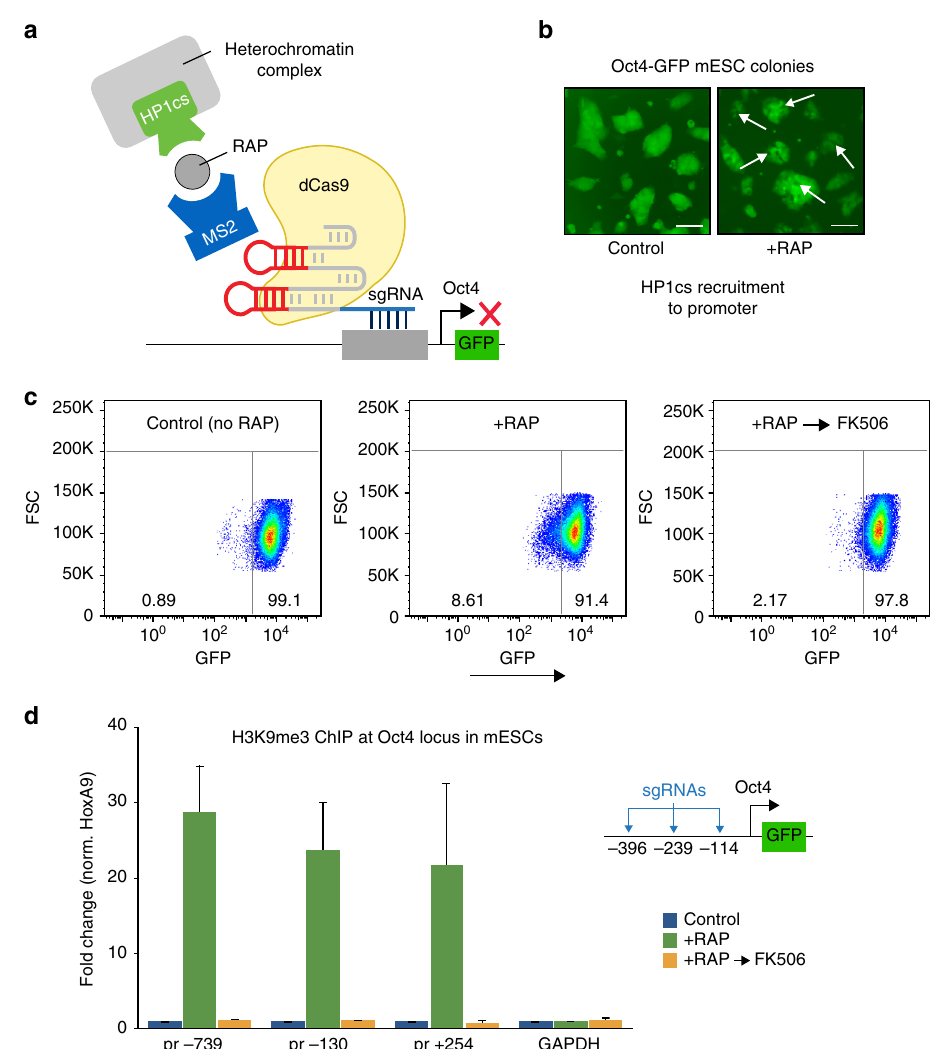
Fig. 2 Reversible heterochromatin complex recruitment regulates Oct4 expression in mESCs. a Schematic representation of heterochromatin complex recruitment to the Oct4 locus in reporter Oct4-GFP mESCs. b Microscopy reveals loss of GFP expression in Oct4-GFP mESC colonies 5 days after RAP treatment to induce HP1cs recruitment. Arrows show examples of GFP-negative cells within Oct4-GFP ESC colonies. Scale bar represents 100 µ m. c FACS analysis shows reversible repression of Oct4-GFP expression in mESCs. After 5 days of RAP to recruit HP1cs to the Oct4 locus, washout experiments using FK506 restore GFP expression levels after 5 days. Numbers represent % of GFP ± cells d H3K9me3 ChIP analysis at the Oct4 locus ( − 739, − 130, and +254 bp from transcriptional start site, TSS) 5 days post RAP treatment and 5 days after washout with FK506. n = 3; error